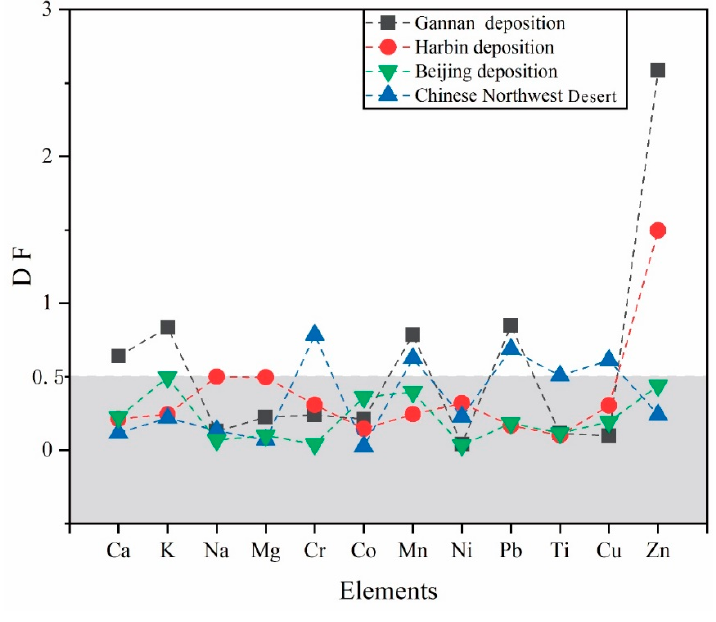
Figure 2. Comparison of the discriminate (DF) index of dry deposition in Gannan and